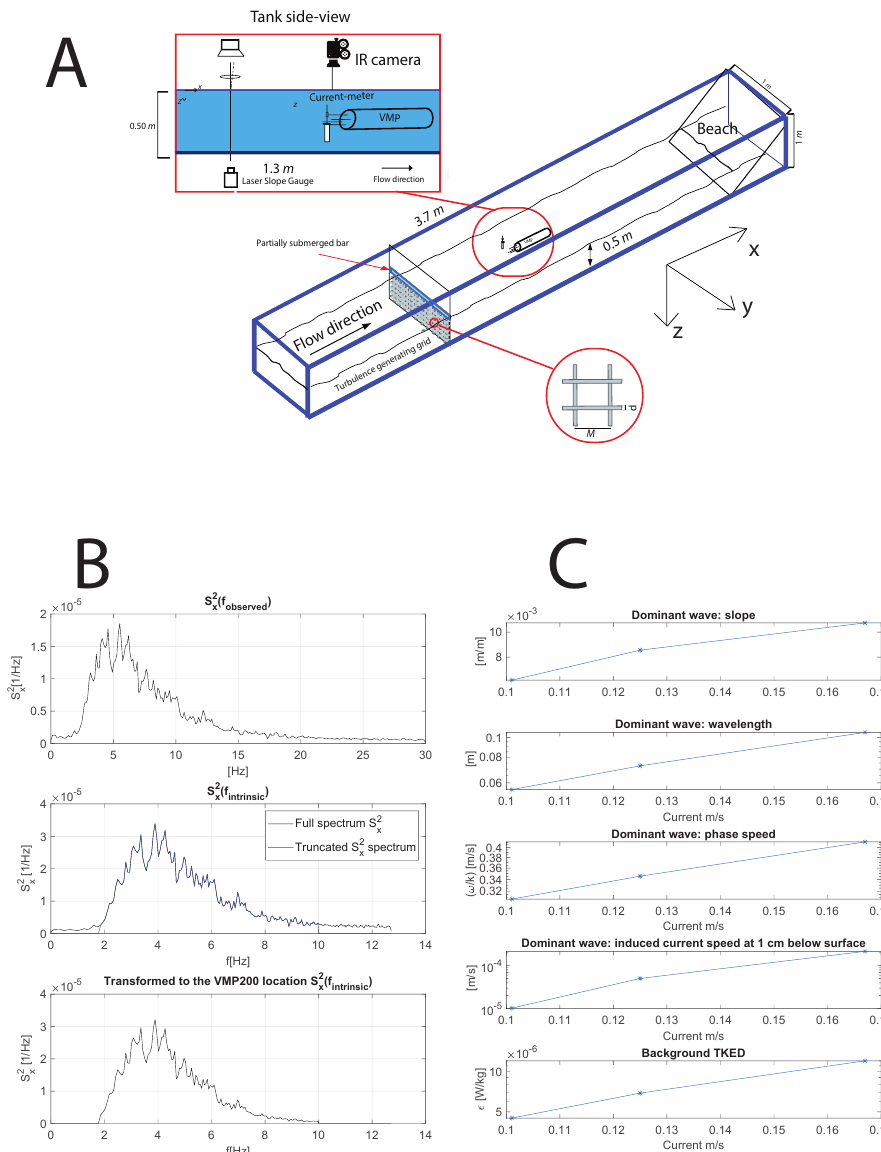
Figure 1. ( A ) Schematic depiction of the experimental setup and the side view of instruments location: VMP200, current meter, IR camera, and details of the grid arrangement. ( B ) Example of observed wave properties for U curr = 0.101 m/s. From the top: (I) Observed directional wave slope variance spectra S 2 x aligned with the tank axis x . (II) Intrinsic directional wave variance spectra. Blueline, the spectra used for calculations. (III) Intrinsic wave variance spectra transformed to the VMP200 site. ( C ) The dominant wave, i.e., the wave with the largest slope, and its properties: wave slope, wavelength, phase speed, and current speed generated by the wave 1 cm below the surface for U curr = 0.101, U curr = 0.125, and U curr = 0.167 m/s. Bottom-the background TKED